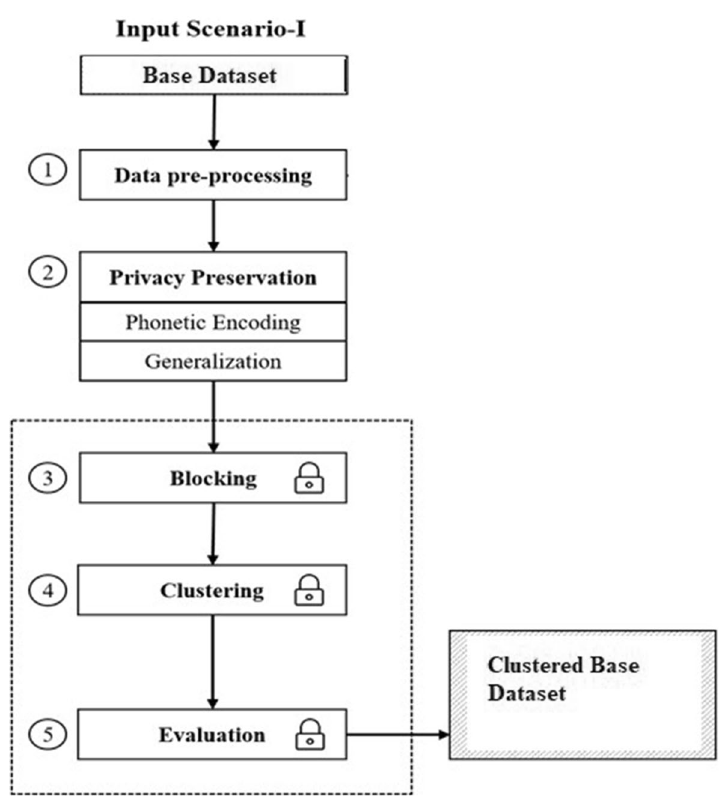
Fig. 5 PPIRL, an end-to-end framework steps for the base